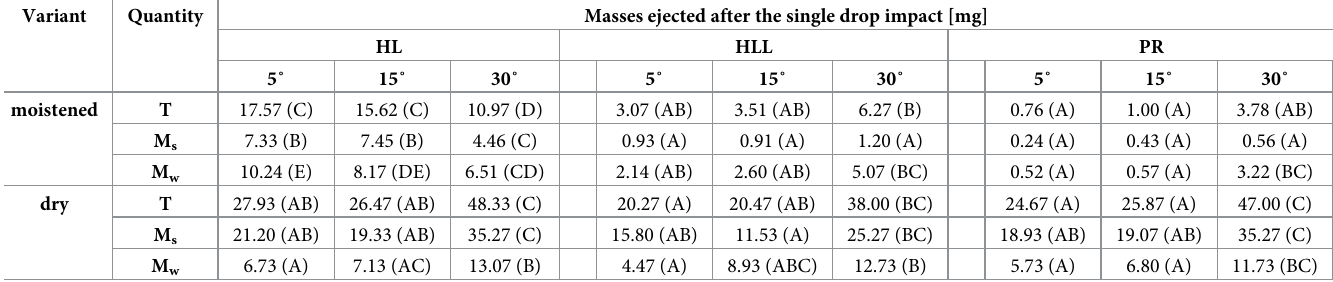
The values are recalculated for a single drop impact. Symbols of measured quantities: T–total mass of ejected material; M w − mass of ejected liquid phase (water); M s − mass of ejected solid phase (soil). Symbols of soils: HL– Haplic Luvisol , HLL– Haplic Luvisol Loamic , PR– Protic Regosol . The letters in parentheses refer to the statistical comparison between investigated soils and inclines for the measured quantities (the same letters in row–no statistically significant